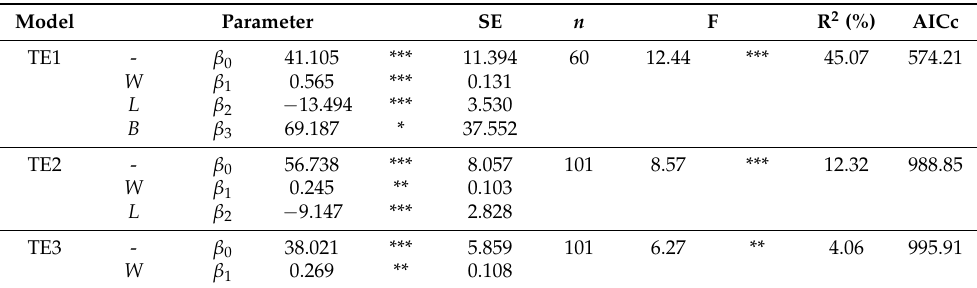
Table 3. Parameter estimates and goodness of fit statistics of the general mixed-effects models for estimating total CO 2 emissions for all land uses.